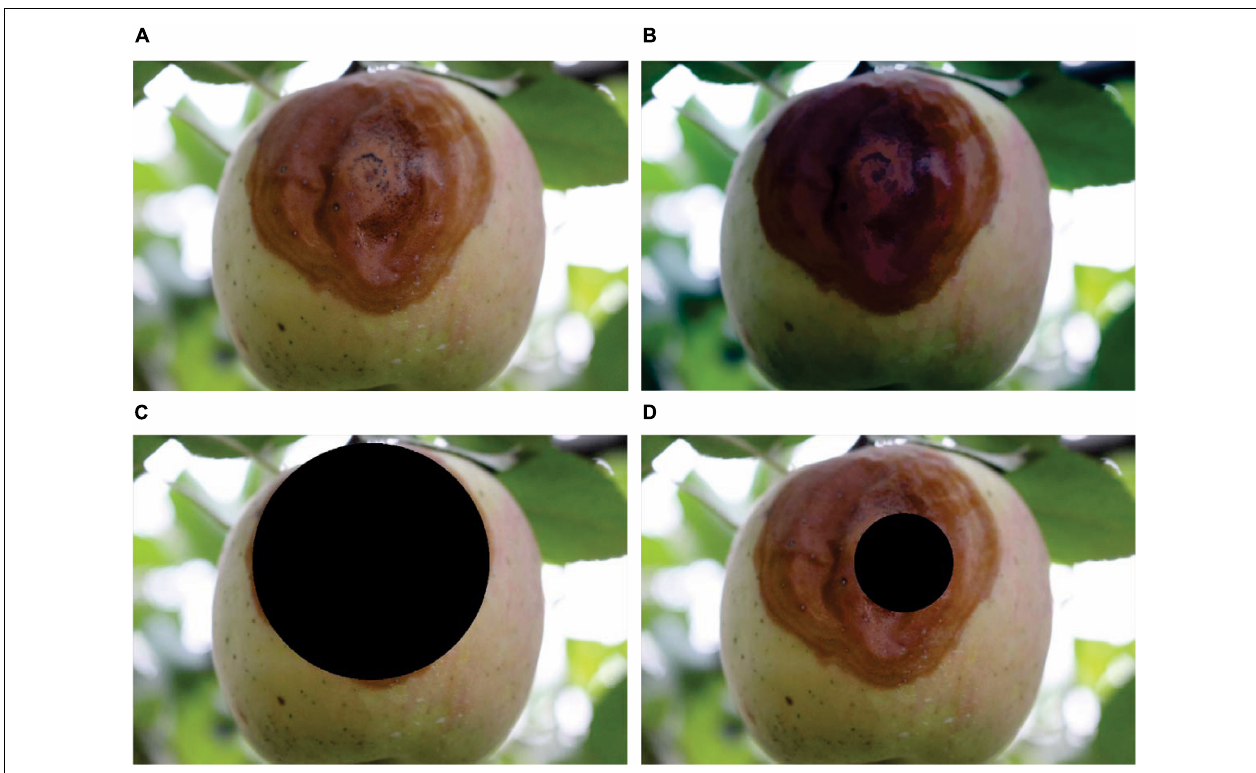
FIGURE 3 | The results of image preprocessing and lesion segmentation for apple ring rot. (A) Original color image. (B) Image after preprocessing. (C) Image after lesion segmentation by using Lesion segmentation method 1 without closing operation. (D) Image after lesion segmentation by using Lesion segmentation method 2 with the closing operation. The black areas in panels (C,D) are the segmented lesions obtained by using Lesion segmentation method 1 and Lesion segmentation method 2,